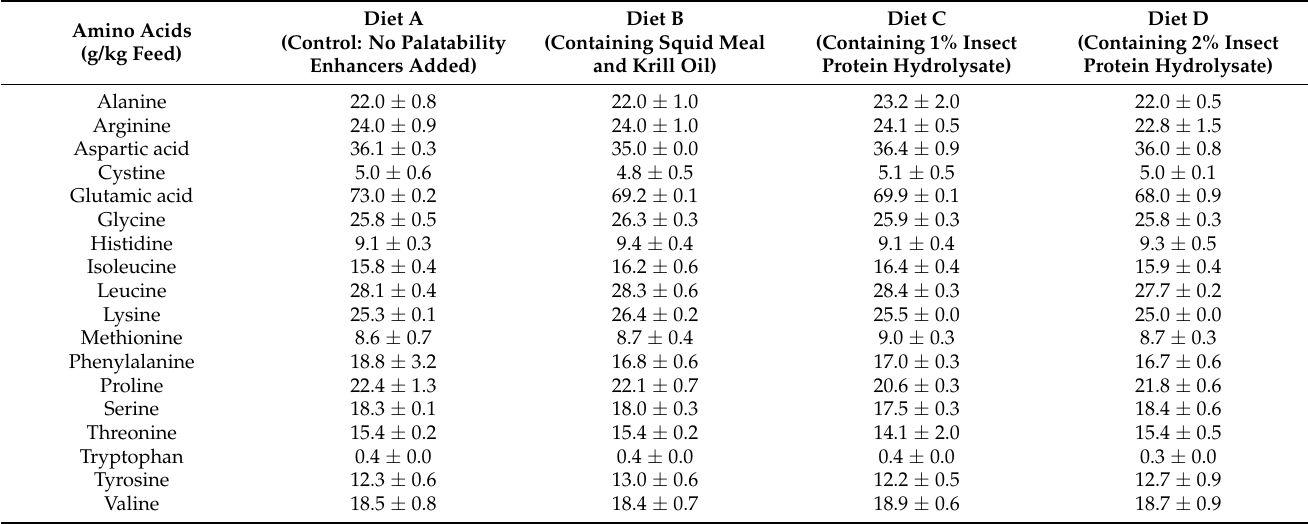
Table 2. Total amino acid composition of four diets used in the study. Diet A Amino Acids (Control: No (g/kg Feed)